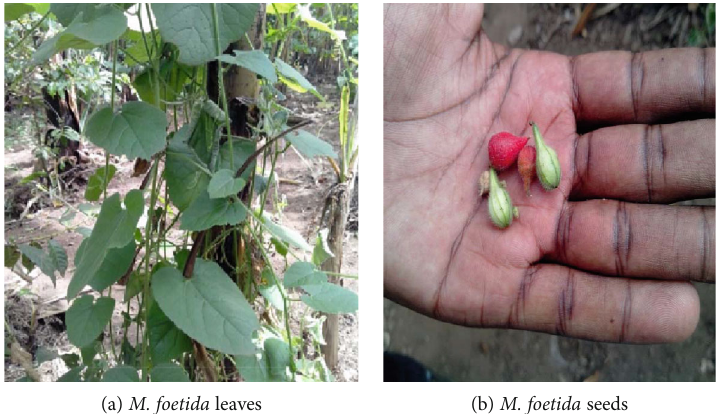
Figure 3: (a) M. foetida leaves. (b) M. foetida seeds. Source: Field survey, 2017.